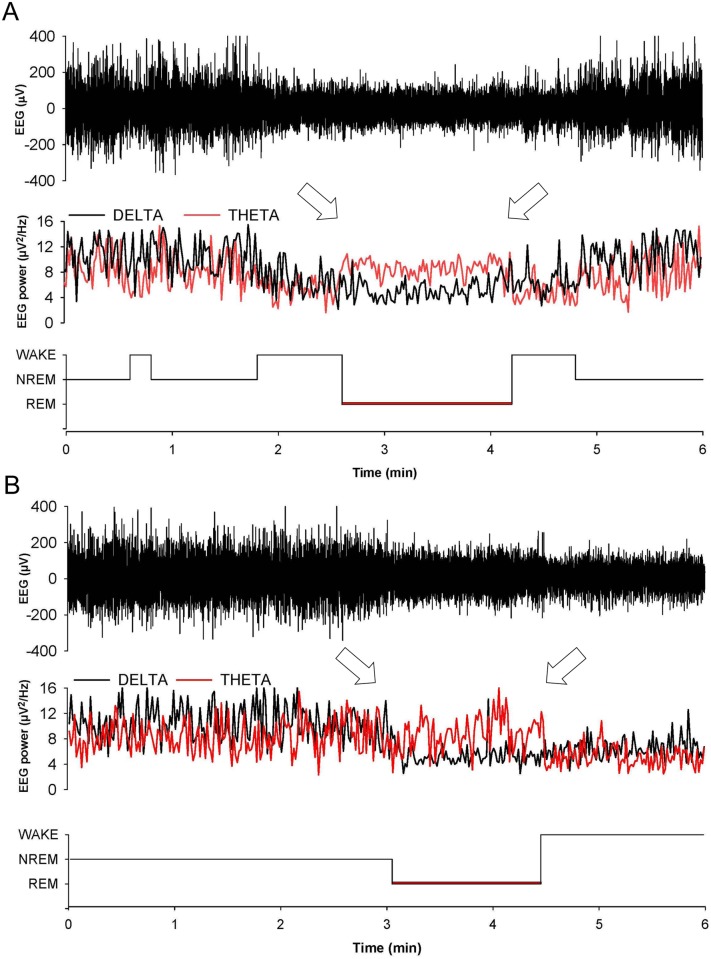
Entry in REM sleep is abnormal in Tg(FFI) mice.Whereas a Tg(FFI-26)/Prnp
0/0 mouse (A) enters REM sleep directly from wakefulness (left arrow), as shown by the hypnogram (lower trace), in a non-Tg/Prnp
+/+ mouse REM sleep is preceded by an episode of NREM sleep (B). Top to bottom: EEG (electroencephalogram), EEG power in the delta (0.5–4 Hz, black line) and theta (6–9 Hz, red line) bands, and the related hypnogram. Arrows indicate the beginning and end of a REM sleep phase.